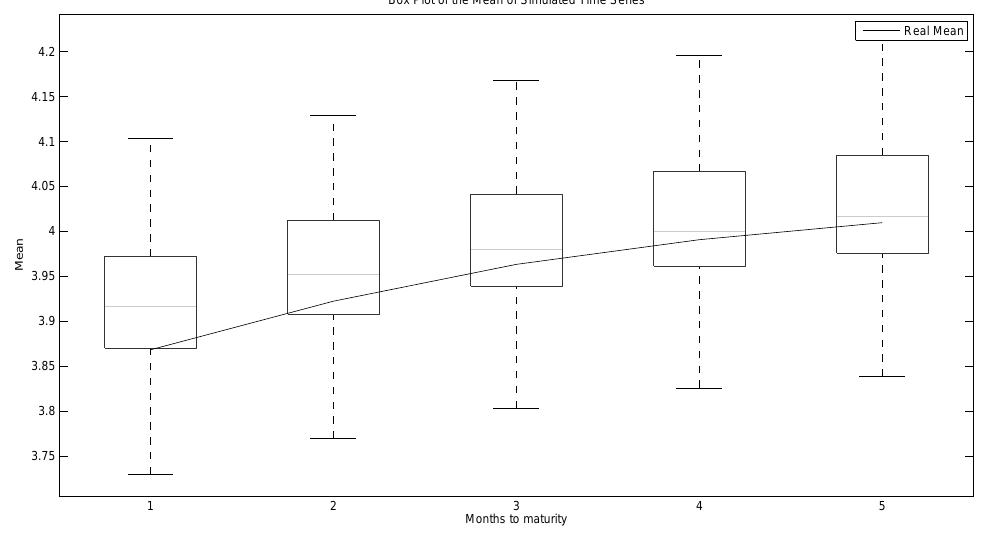
Figure 9. Box plots of the mean of simulated time series.